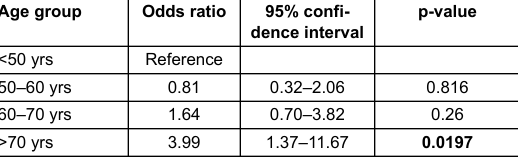
Table 4: Odds ratios for Clavien ≥3 complications by age groups.